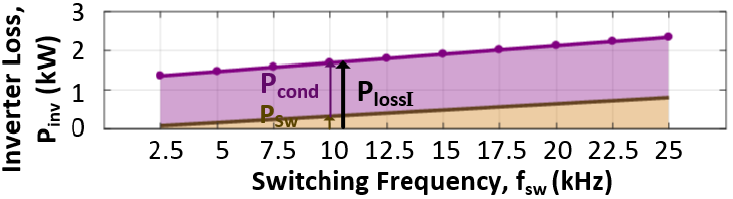
Figure 12. Variations in total power loss components of the traction inverter against switching frequency when V dc = 750 V, V s = 480 V l-to-l, f s = 60 Hz, and n r = 1779 rpm in delivering 165 kVA to the motor at 0.81 pf lag.